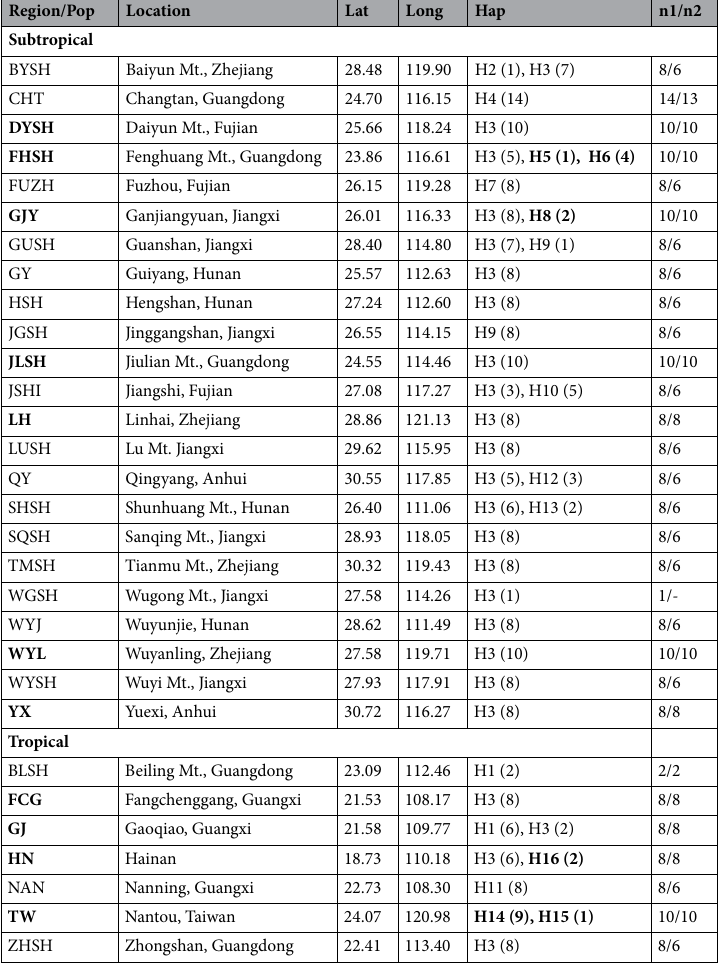
Table 1. Population information and chloroplast DNA haplotype distributions. Newly added populations and derived haplotypes are labeled in bold. n1/n2 represent sampling number of chloroplast DNA and low- copy nuclear genes (LCGs), respectively. Pop populations, Lat latitude, Long longitude, Hap chloroplast DNA